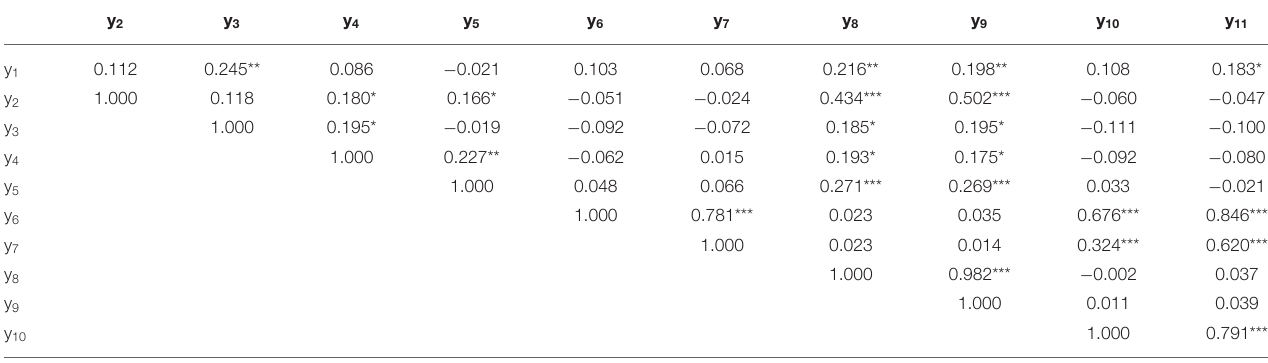
TABLE 2 | Pearson correlation coefficients of each traits of the